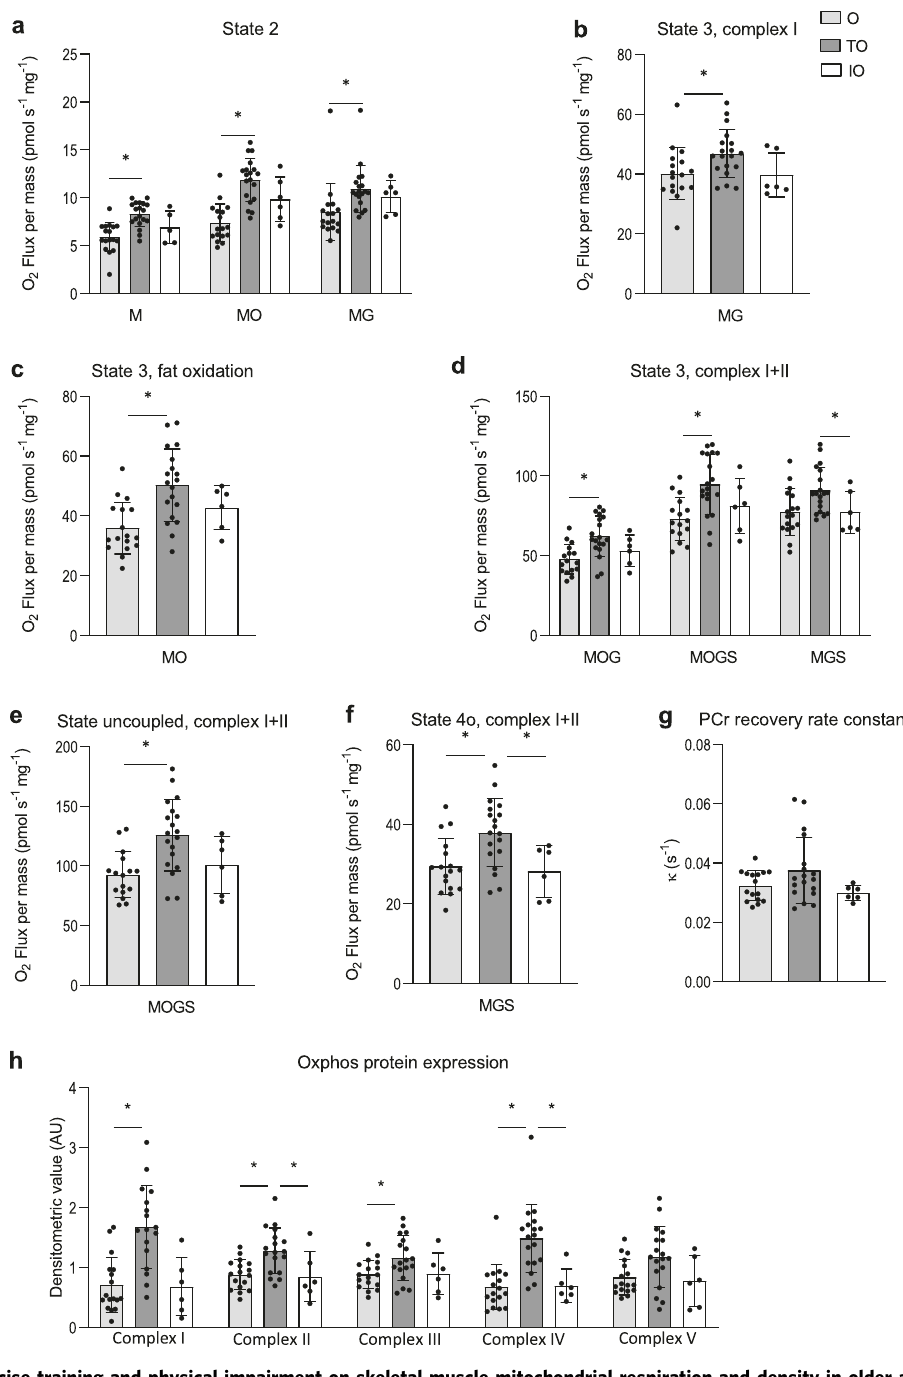
Fig. 6 Effect of exercise training and physical impairment on skeletal muscle mitochondrial respiration and density in older adults. a Mitochondrial respiration upon substrates only (state 2) (O, n = 17; TO, n = 19; IO, n = 6). b ADP-stimulated respiration (state 3) fueled by Complex I-linked substrates (O, n = 17; TO, n = 19; IO, n = 6). c State 3 respiration upon a lipid substrate (O, n = 17; TO, n = 19; IO, n = 6). d State 3 respiration upon parallel electron input into Complex I and II (O, n = 17; TO, n = 19; IO, n = 6). e Maximal uncoupled respiration upon FCCP (O, n = 17; TO, n = 19; IO, n = 6). f Mitochondrial leak respiration (state 4o) (O, n = 17; TO, n = 19; IO, n = 6). g In vivo 31 P-MRS estimate of mitochondrial oxidative capacity κ (O, n = 16; TO, n = 18; IO, n = 6). h Mitochondrial protein expression of oxidative phosphorylation (OXPHOS) complex I, complex II, complex III, complex IV, and complex V (O, n = 17; TO, n = 18; IO, n = 6). Light gray bars represent normally active older adults (O); dark gray bars represent trained older adults (TO); white bars represent physically impaired older adults (IO). PCr data from one O participant has been excluded from analysis due to a pH decline below 6.9. PCr from a TO participant has been excluded due to issues regarding the analysis. From one TO not enough muscle tissue was available for the OXPHOS analysis. Data presented in panels a and g were analyzed by two-sided Kruskal – Wallis tests followed by Bonferroni correction. Data presented in panels b – f and h were analyzed by one-way ANOVA with Tukey ’ s post-hoc test. Values are presented as mean ± SD (with individual data points), asterisk denotes signi fi cant differences between two groups ( p < 0.05). M malate, O octanoyl-carnitine, G glutamate, S succinate, κ phosphocreatine resynthesis rate constant.